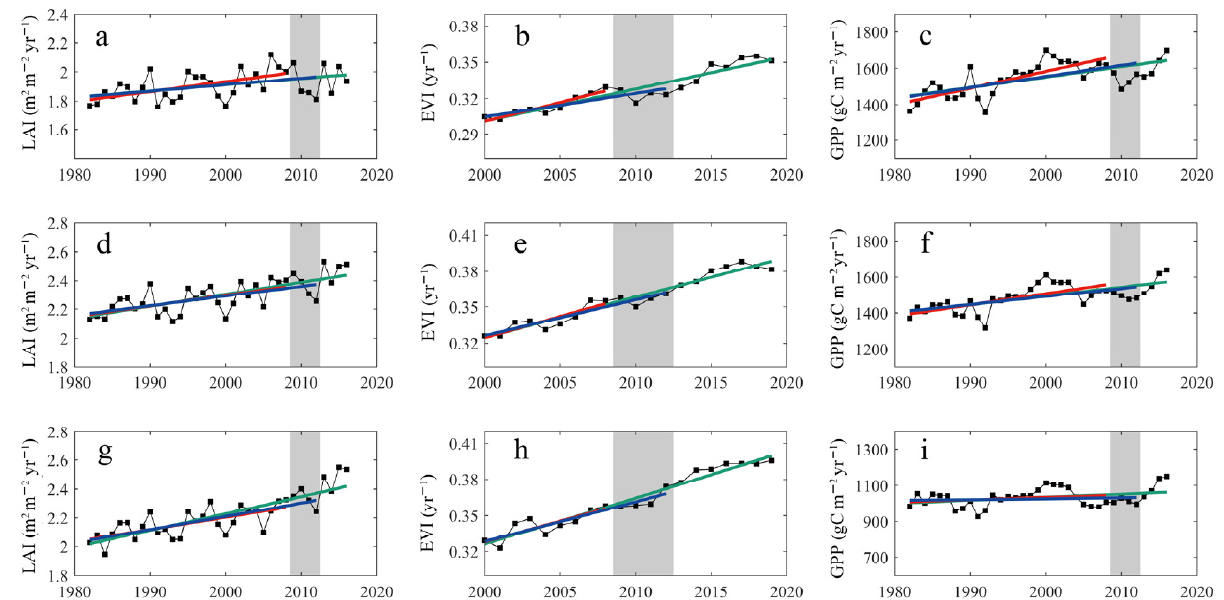
Figure 6. Annual change trend of vegetation indictors: the gray shaded part is the drought period, ( a – c ) are the annual change trends in the heavy drought area, ( d – f ) are the annual change trends in the slight drought area, and ( g – i ) are the annual change trends in the drought-free area; red is the change trend before drought (BDT), blue is the change trend after drought (ADT), and green is the long-term trend